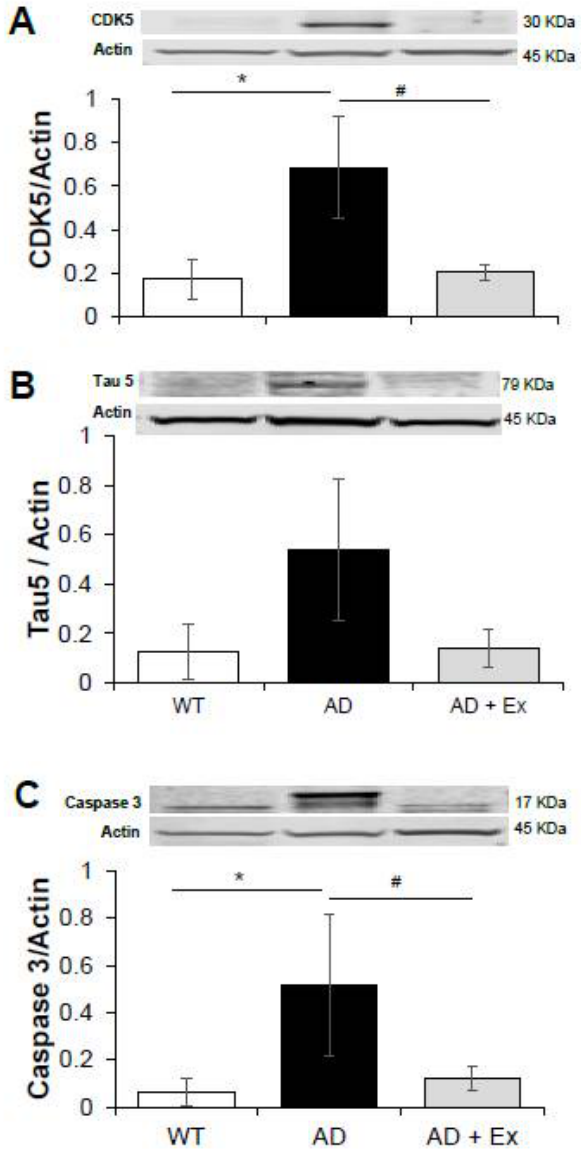
Figure 6. The effects of exercise training on total protein expression of AD-related proteins in 3xTg mouse jejunum. CDK5 ( A ), Tau5 ( B ) and caspase 3 ( C ) of jejunum from 3xTg-AD mice. Values are reported as mean ± SEM for 3 to 5 mice per group. * indicates significance compared to WT control mice, p < 0.05; # indicates significance compared to 3xTg-AD mice, p < 0.05. CDK, cyclin dependent kinase; AD, Alzheimer’s disease; WT, wild type; Ex, exercise.